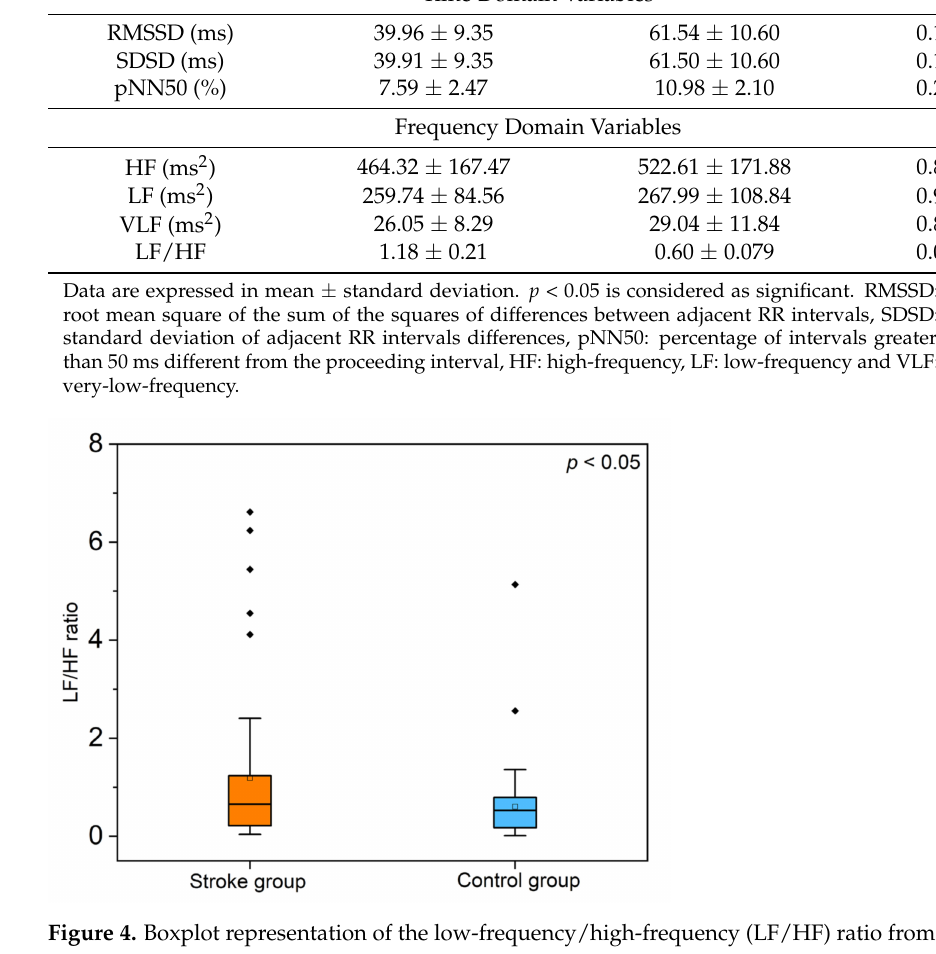
Figure 4. Boxplot representation of the low-frequency/high-frequency (LF/HF) ratio from the heart rate variability (HRV) spectral domain analysis ( p < 0.05 between the groups).